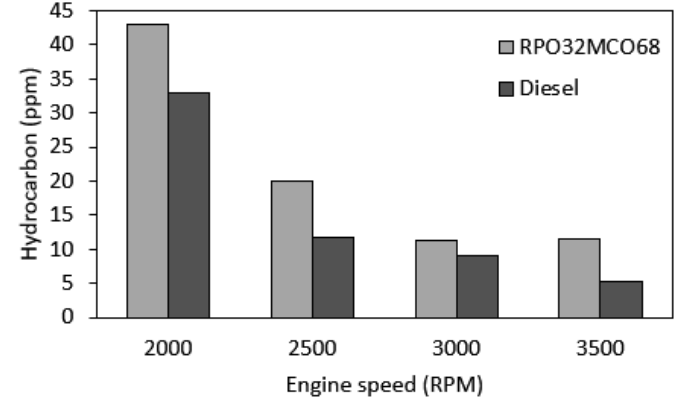
Figure 15. Comparison of unburned hydrocarbon emission as a function of engine speeds.